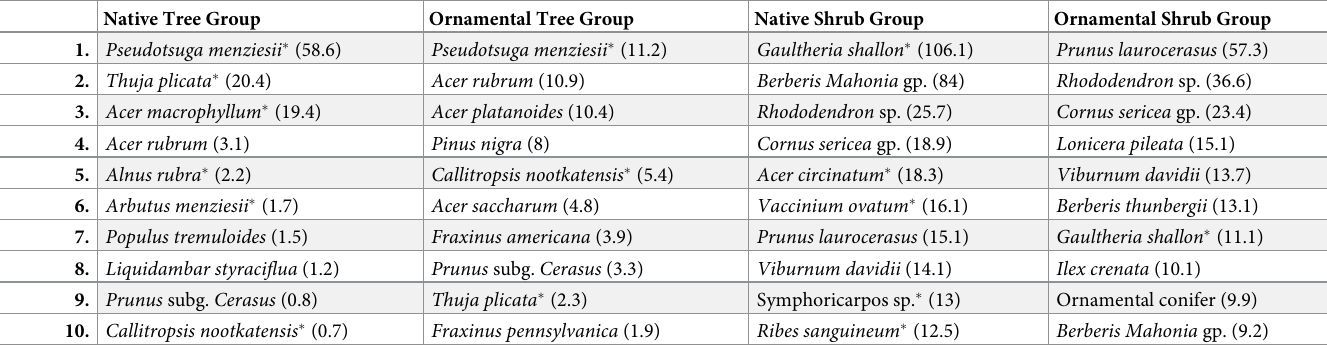
Table 4. Rank abundance of tree and shrub taxa for each community group identified by flexible-beta cluster analysis. Native Tree Group Ornamental Tree Group Native Shrub